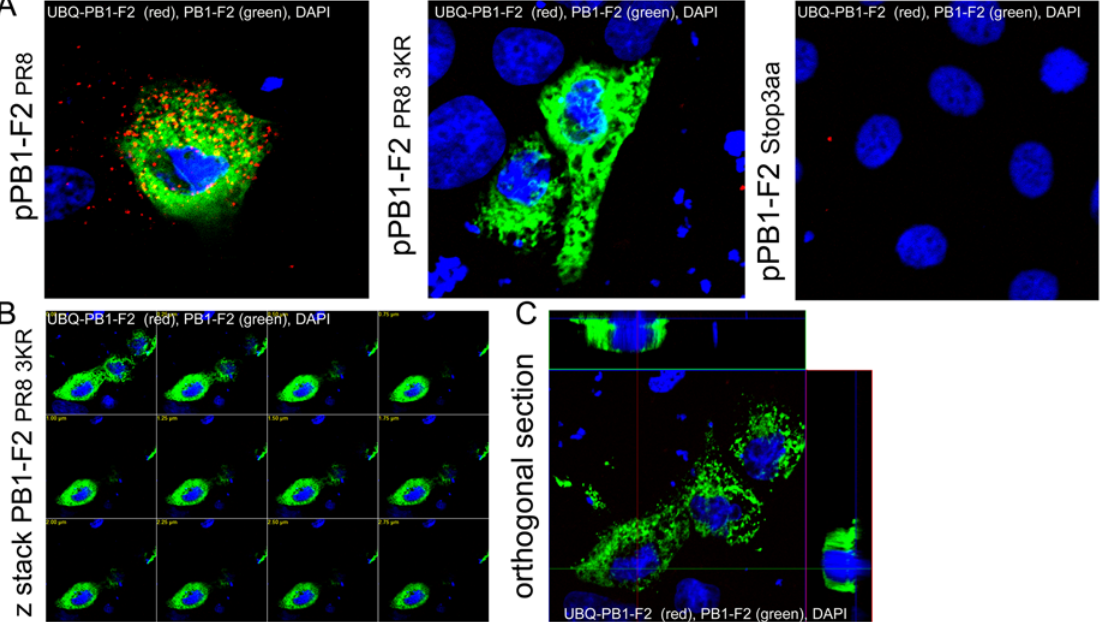
Fig 3. Identification of the cluster of C-terminal K residues as an ubiquitination site of PB1-F2. MDCK cells were transfected transiently with 1 μ g pPB1-F2 PR8, pPB1-F2 PR8 3KR or pPB1-F2 Stop3aa. At 24 hr p.t., the cells were fixed and stained for the presence of the subpopulation of ubiquitinated PB1-F2 (labeled UBQ-PB1-F2, red spots) and PB1-F2 (green). (A) and analyzed with confocal microscopy. (B) Z stack acquisition was applied to confirm the absence of UBQ-PB1-F2 (red spots), regardless of the focal plane displayed. Orthogonal section reconstruction confirmed that the distribution of PB1-F2 PR8 3KR was equal to the wt PB1-F2 protein. (C) No UBQ-PB1-F2 (red spots) was observed in the cells transfected with pPB1-F2 PR8 3KR in multiple focal planes orthogonal section reconstruction. The nuclei were stained with